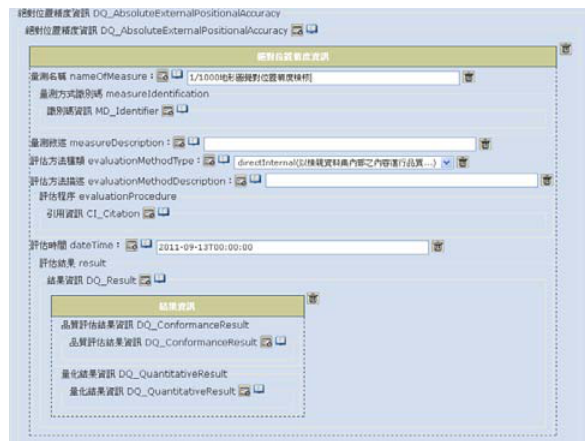
Figure 3 Interface for metadata entry